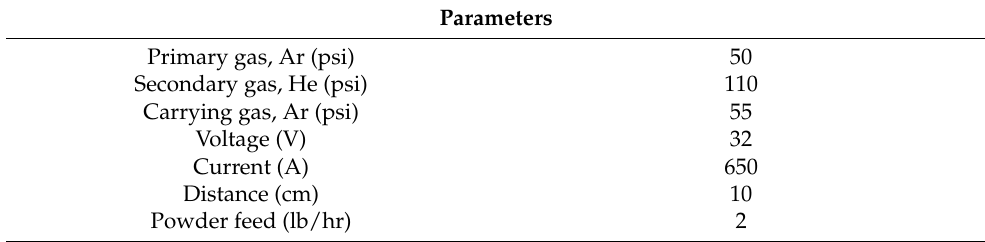
Table 2. Air plasma spray (APS)